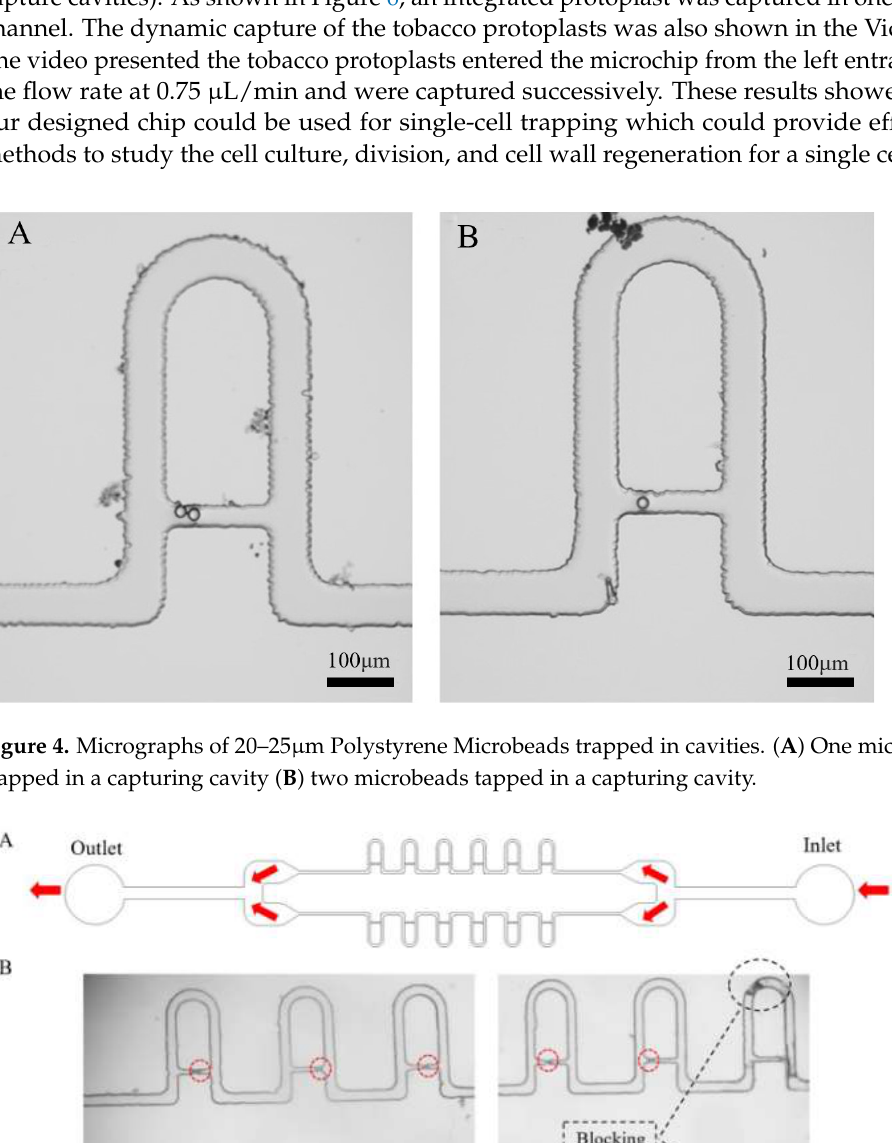
Figure 6. ( A ) Enlarged microscopic image of one single tobacco protoplast trapped. ( B ) Partial enlargement of figure A. 4. Conclusions The isolation and capture of a single protoplast are most important to gene function verification, subcellular localization, and single-cell sequencing. In this study, a dual- channel microfluidic chip based on PDMS with multi-capture cavities was designed. The theory was discussed to design the geometry of this chip. The capture mechanism of the single cell in dual-channel microfluidic chip was studied by simulation analysis. Our re- sults showed that a single polystyrene microsphere or tobacco protoplast was successfully isolated and trapped in this chip. The precise design of the capture cavities and control of the inlet velocity maintained the trapped cells more stable in the cavities. The capture ef- ficiency of the chip was 83.33% for the single tobacco protoplast when the inlet flow rate was 0.75 μL/min. In addition, the dynamic capture of the polystyrene microsphere and tobacco protoplasts was also presented. Therefore, this study not only provides a new strategy for the subsequent high throughput of single protoplast research, but also lay a